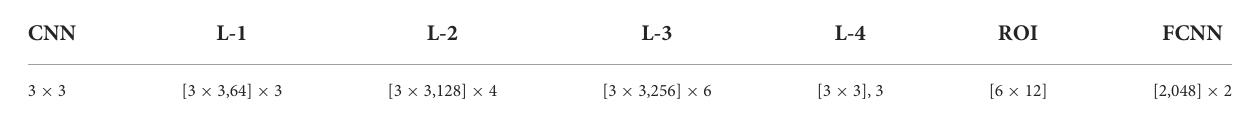
TABLE 2 Layer configuration of HWNet v2.